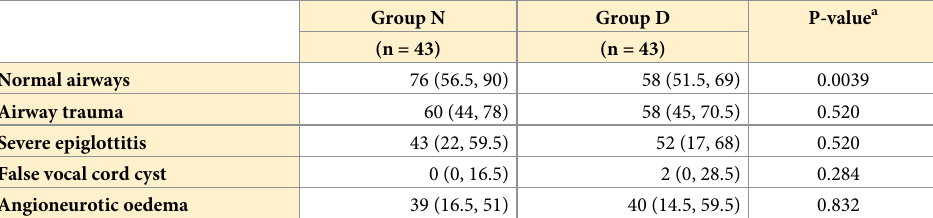
Table 3. ORSIM 1 scores’ (%) comparison between groups during final